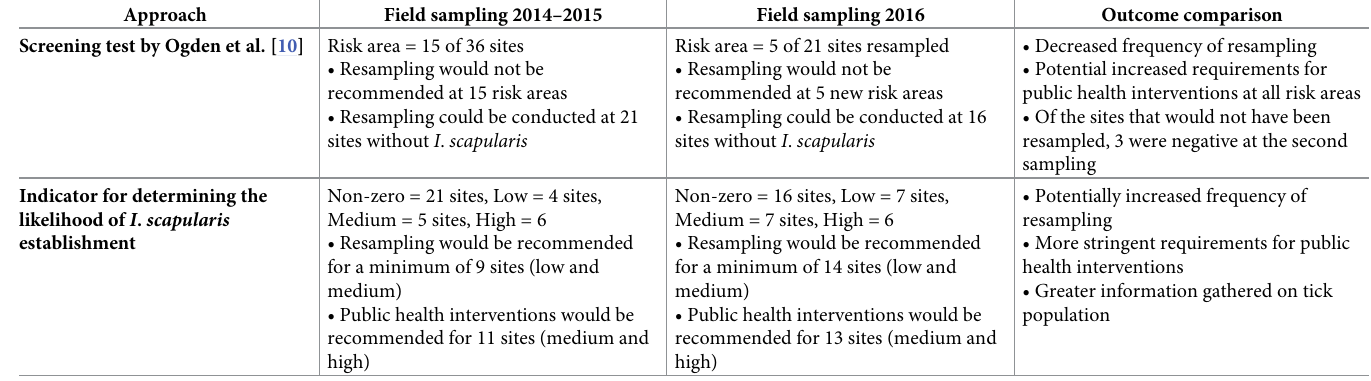
Table 3. The recommendation for public health actions following each field sampling timeframe based on the screening test outlined by Ogden et al. [10] and our indicator.